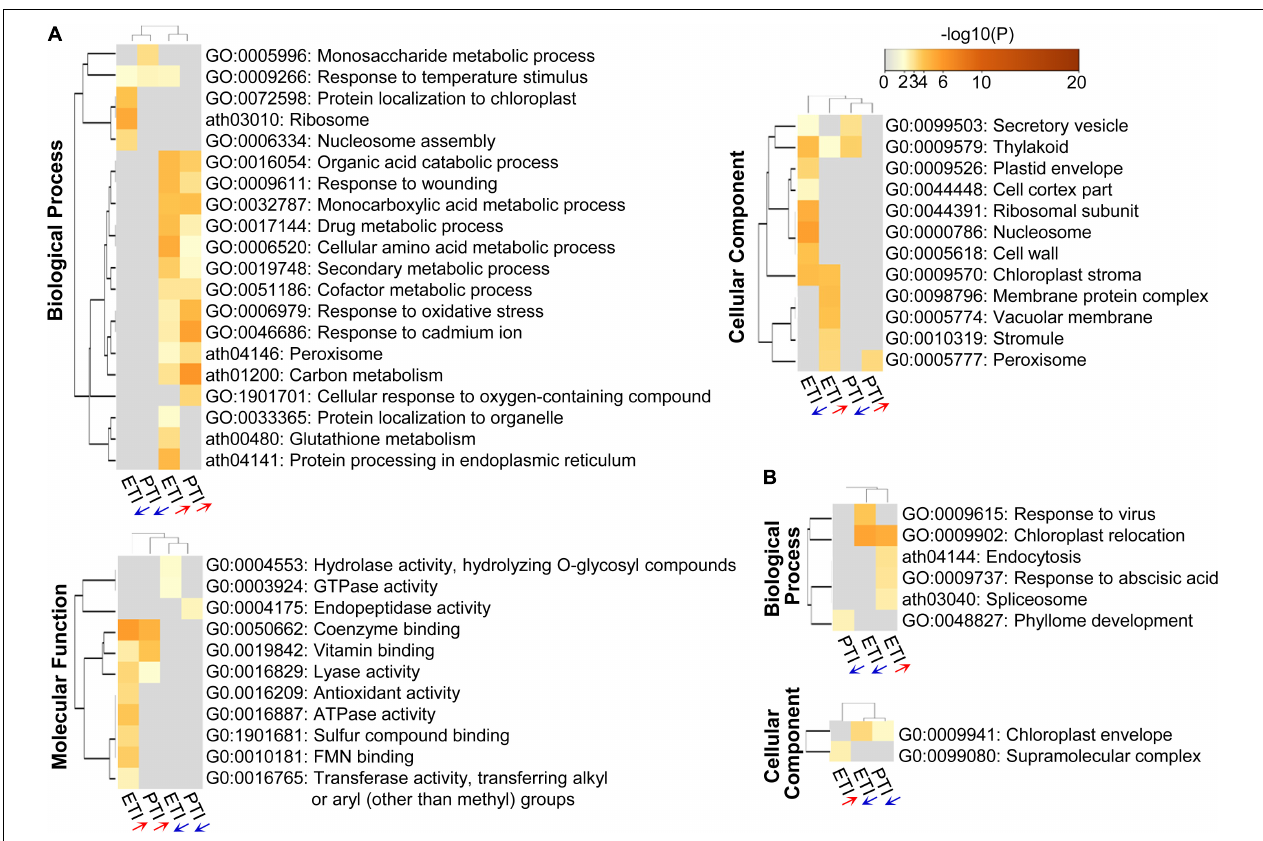
FIGURE 2 | Heatmap of GO enriched terms across the input protein lists, colored by p -values. (A) DR proteins; and (B) DR phosphoproteins. The red or blue arrows below the columns indicate the lists containing increased or decreased proteins/phosphoproteins,